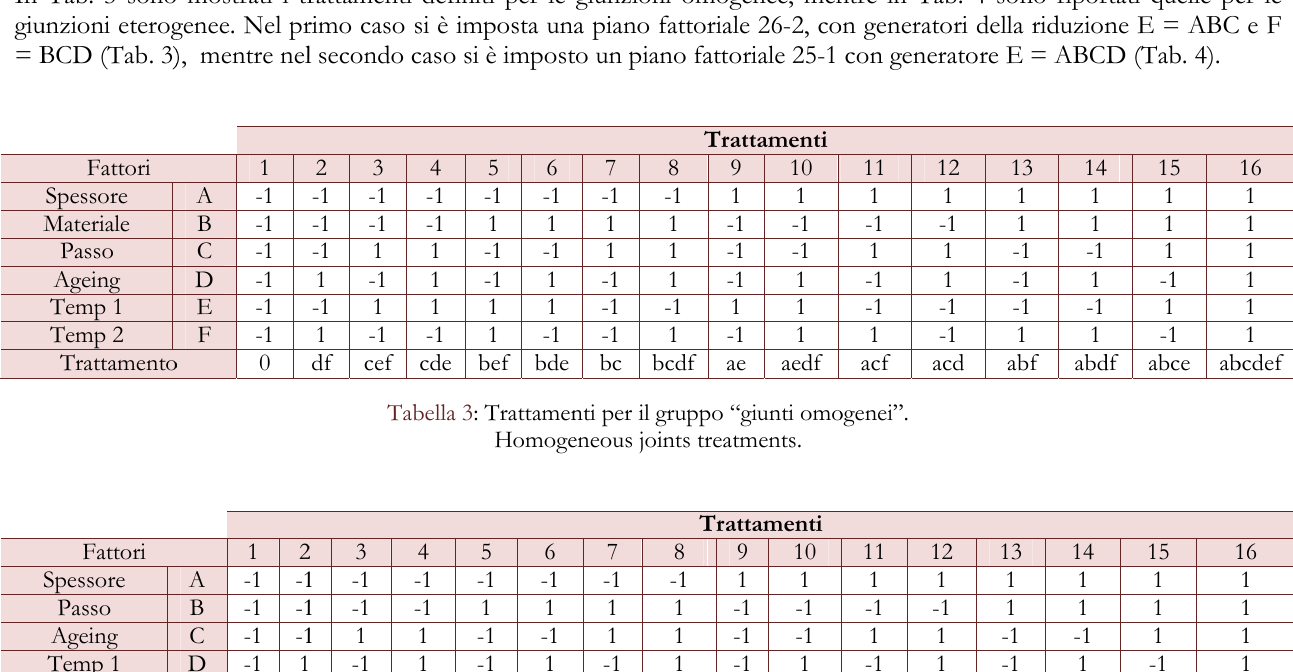
Spessore Passo Temp 2